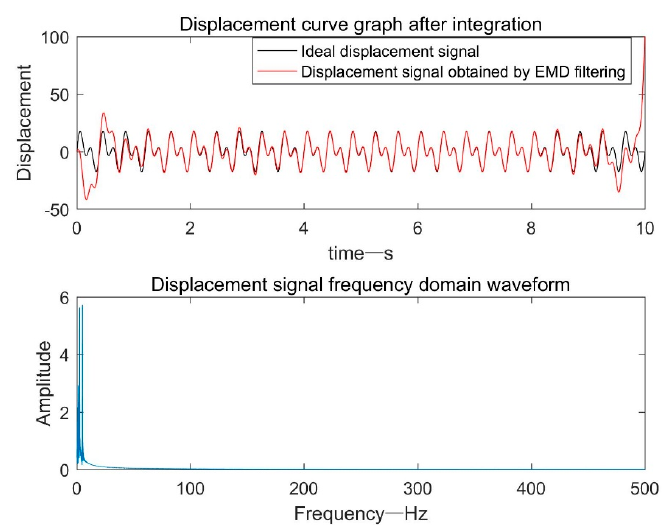
Figure 5. Displacement signal after EMD adaptive filtering.